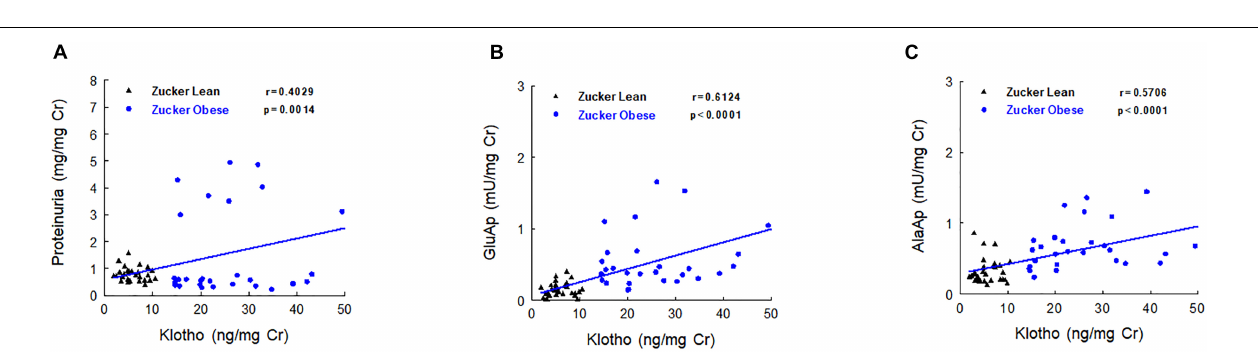
FIGURE 4 | Correlations between urinary Klotho and proteinuria (A) , urinary GluAp (B) and urinary AlaAP (C) excreted at 2, 5, and 8 months old, when all animals (lean and obese Zucker rats) were pooled in a common regression line.